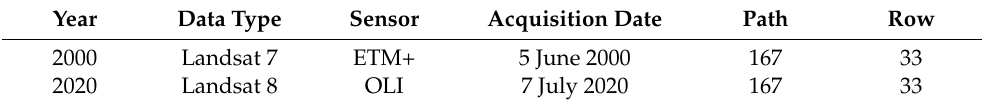
Table 1. Details of imagery used in the study